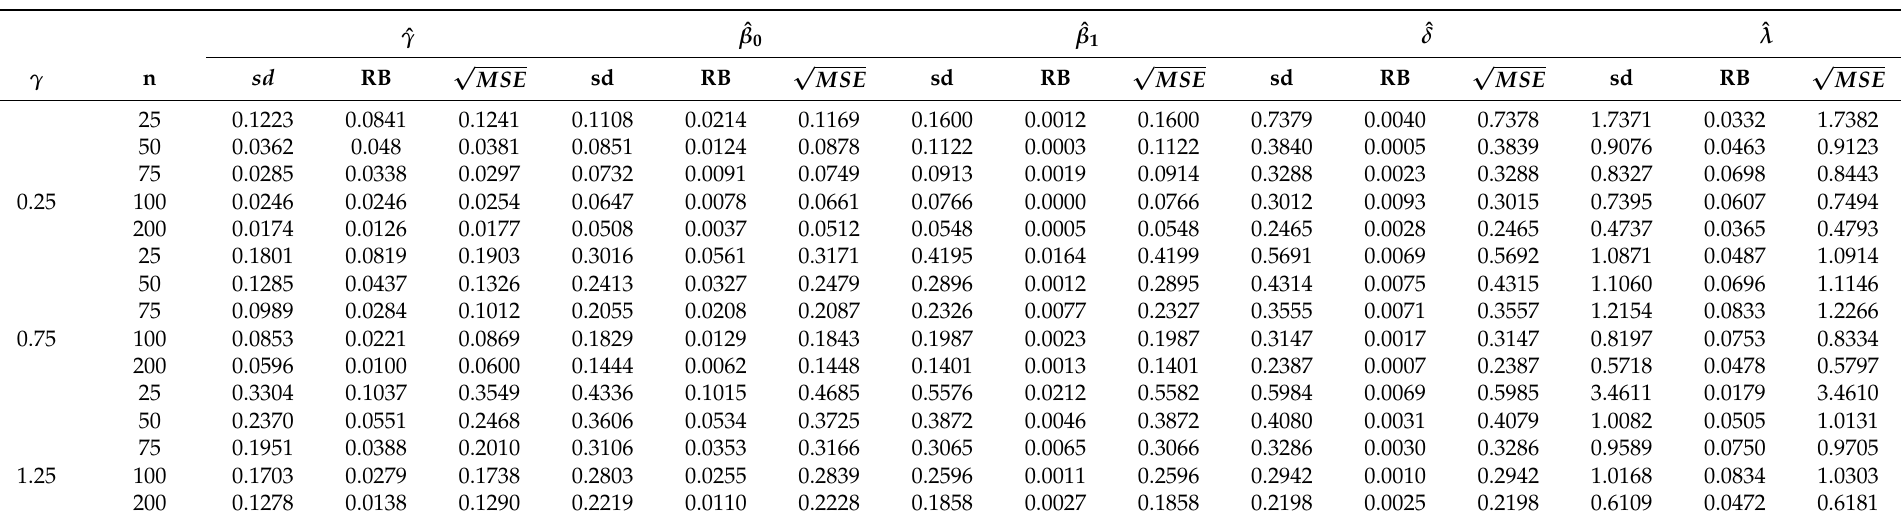
√ MSE for the FSHN ( γ ,1.75,1.25, − 1.5,2 )